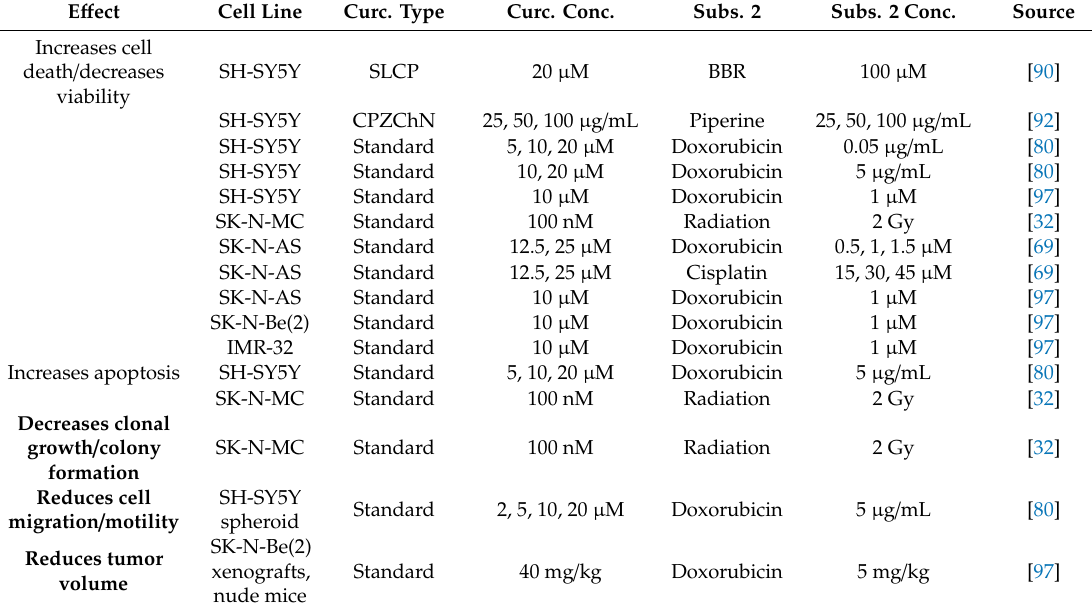
Table 2. Synergistic anticancer e ff ects of curcumin and other natural substances, conventional chemotherapeutic drugs, or radiation therapy on NB cell lines. While solid lipid curcumin particles (SLCP) were trialed with BBR and CPZChN with piperine, pure (or “standard”) curcumin was trialed with doxorubicin, cisplatin, and radiation therapy. Downregulations, decreases, and inhibitions are in bold. “Curc.” refers to “Curcumin”, “Conc.” refers to “Concentration”, and “Subs.” refers to “Substance”. E ff